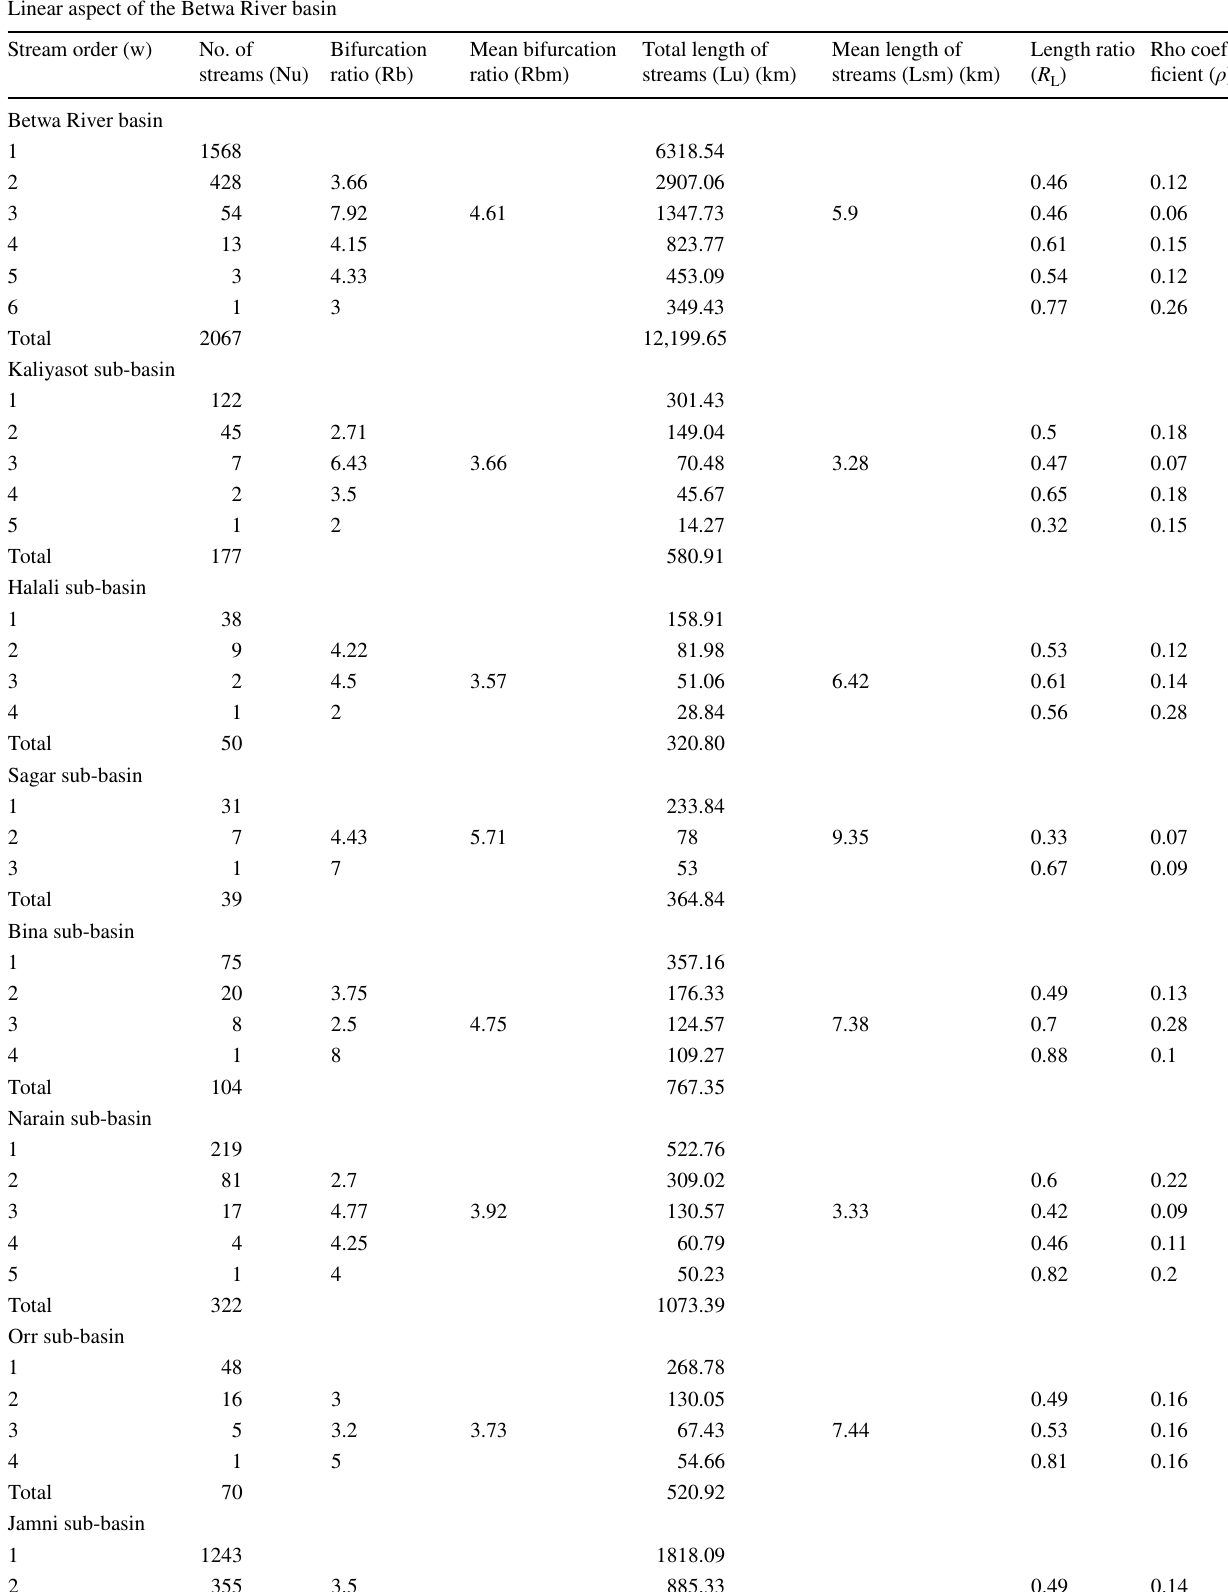
Table 3 Linear aspect of the Betwa River basin and sub-basins Linear aspect of the Betwa River